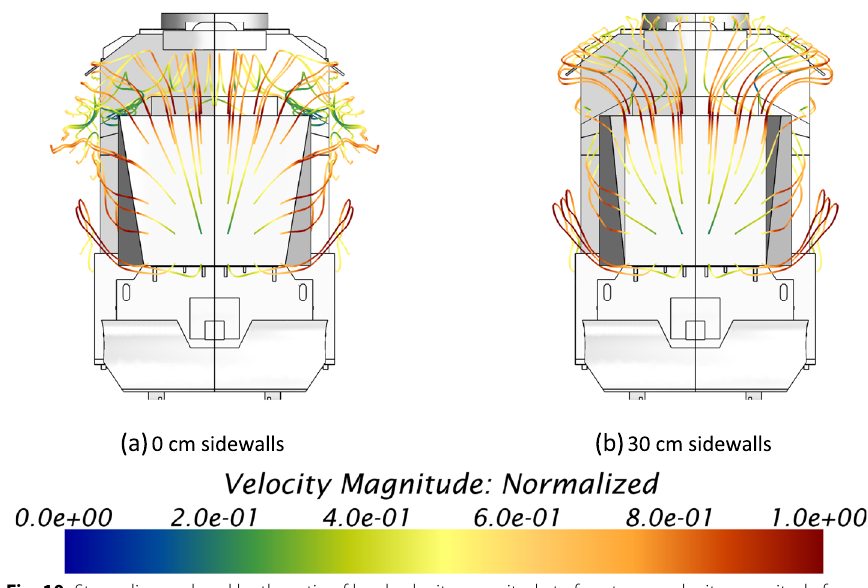
Fig. 10 Streamlines colored by the ratio of local velocity magnitude to freestream velocity magnitude for two secondary fairing geometries as seen from in front of the train: (a) 0 cm sidewalls and (b) 30 cm sidewalls